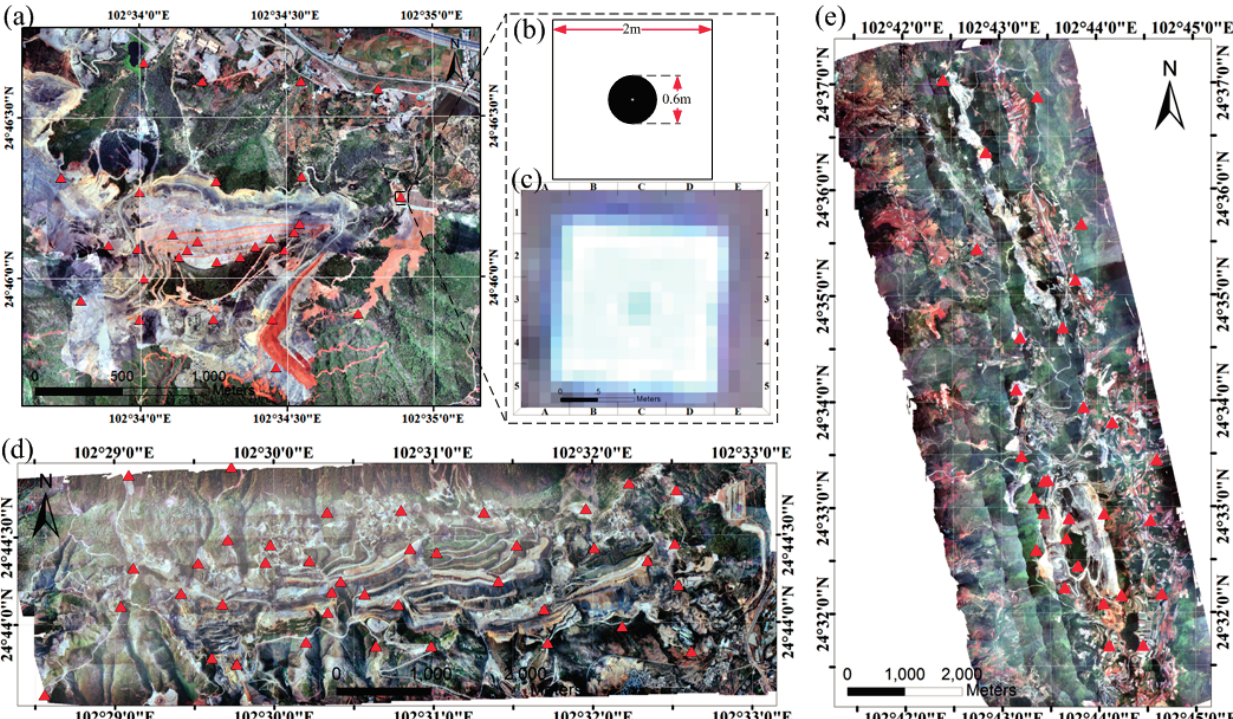
Figure 4. Distribution of GCPs in the study area. ( a ) configuration of the GCPs (delineated as red triangles) in the Jianshan area; ( b ) designed pattern of the GCPs; ( c ) example of a GCP in the UAV image; ( d ) configuration of the GCPs in the Kunyang area; ( e ) configuration of the GCPs in the Jinning